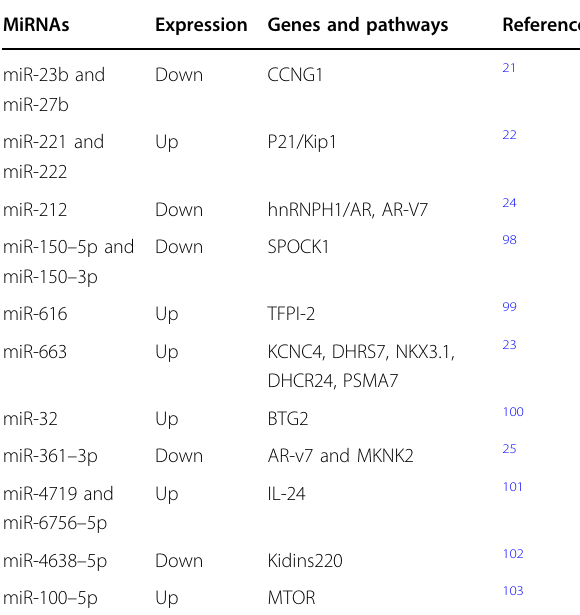
Table 1 MiRNA and castration resistance in prostate cancer.